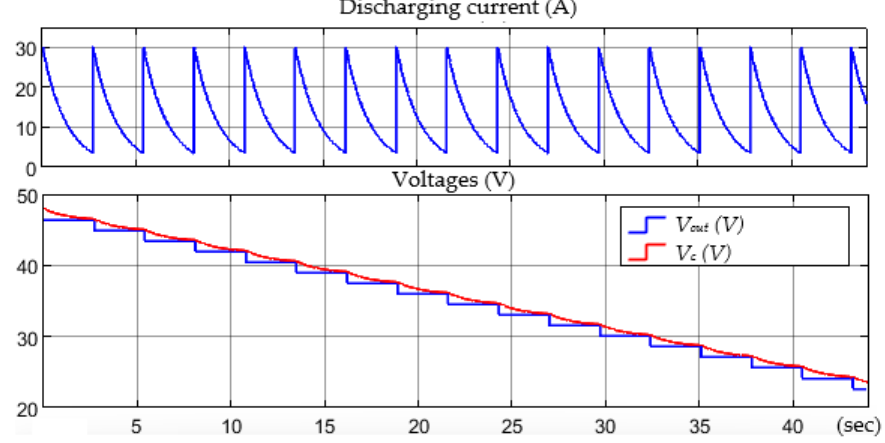
Figure 45. Discharging simulation result diagrams.